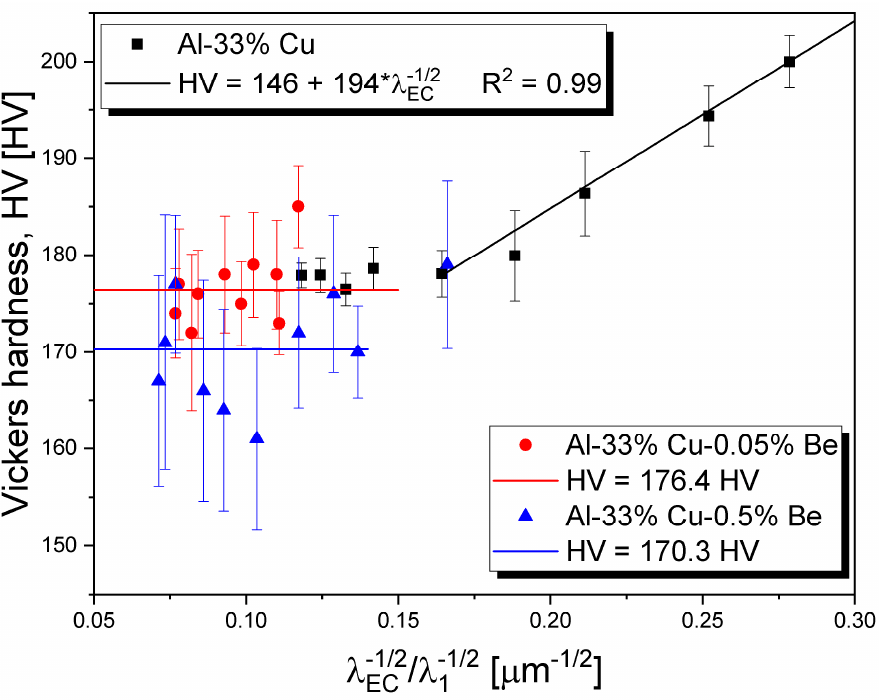
Figure 14. Vickers hardness of Al-33 wt.%Cu data from [19], Al-33 wt.%Cu-0.05 wt.%Be and Al-33 wt.%Cu-0.5 wt.%Be alloys as a function of λ EC − 1/2 / λ 1 − 1/2 .